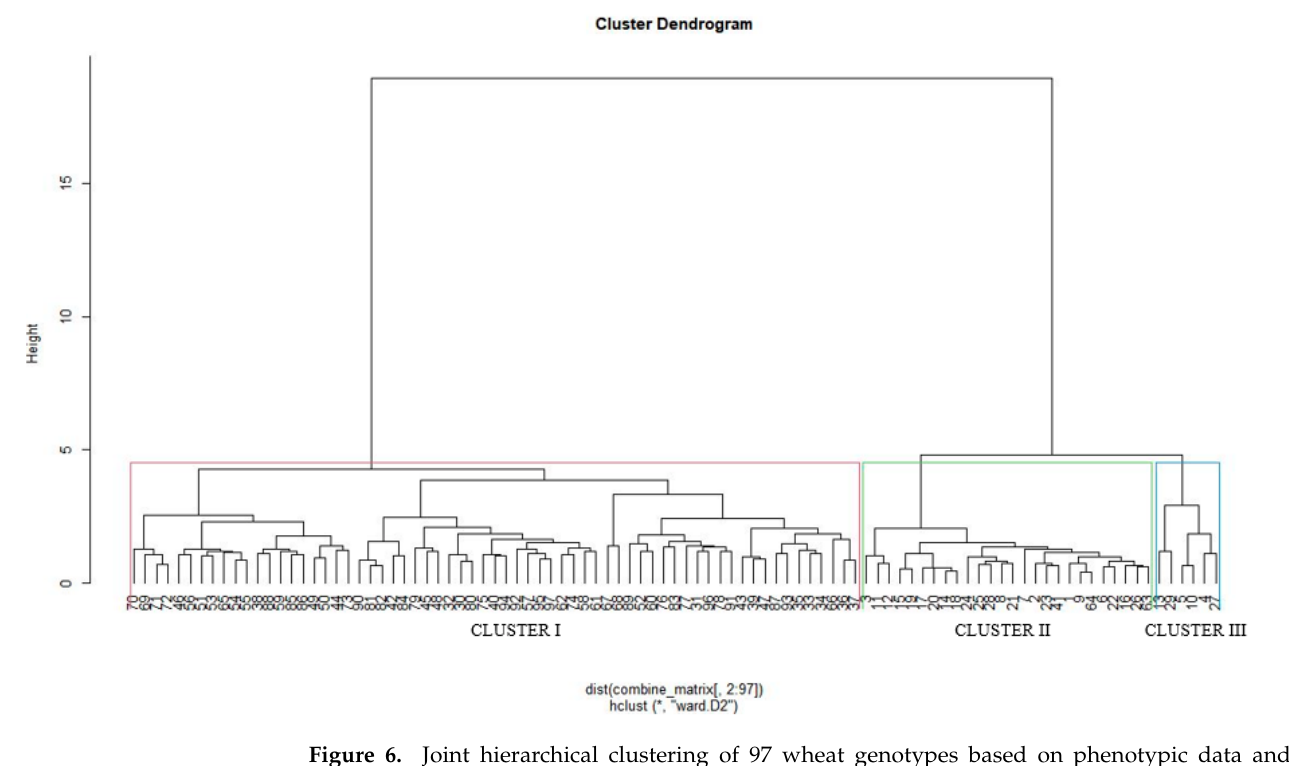
Figure 6. Joint hierarchical clustering of 97 wheat genotypes based on phenotypic data and 16,382 SNP markers. Clusters are separated by color lines.